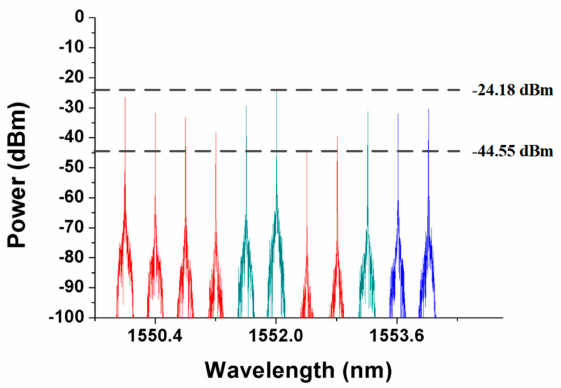
Figure 14. Detection signals received by the CO when the second phase of the second detection step is